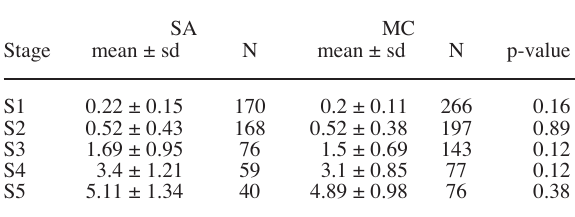
T ABLE 2. – Chasmagnathus granulatus . Mean gonadosomatic index (GSI, the relative weight of the ovaries) ± 1 standard deviation, and number of females with S1-S5 in San Antonio (SA) and Mar Chiquita (MC). P-value, with Student-t between populations with the same ovarian stage.